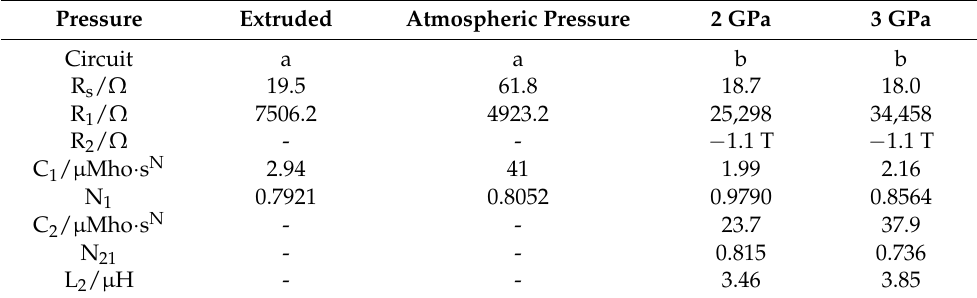
Table 3. EIS fitting results for the extruded Al-Zn-Mg-Cu alloy annealed at different pressures.